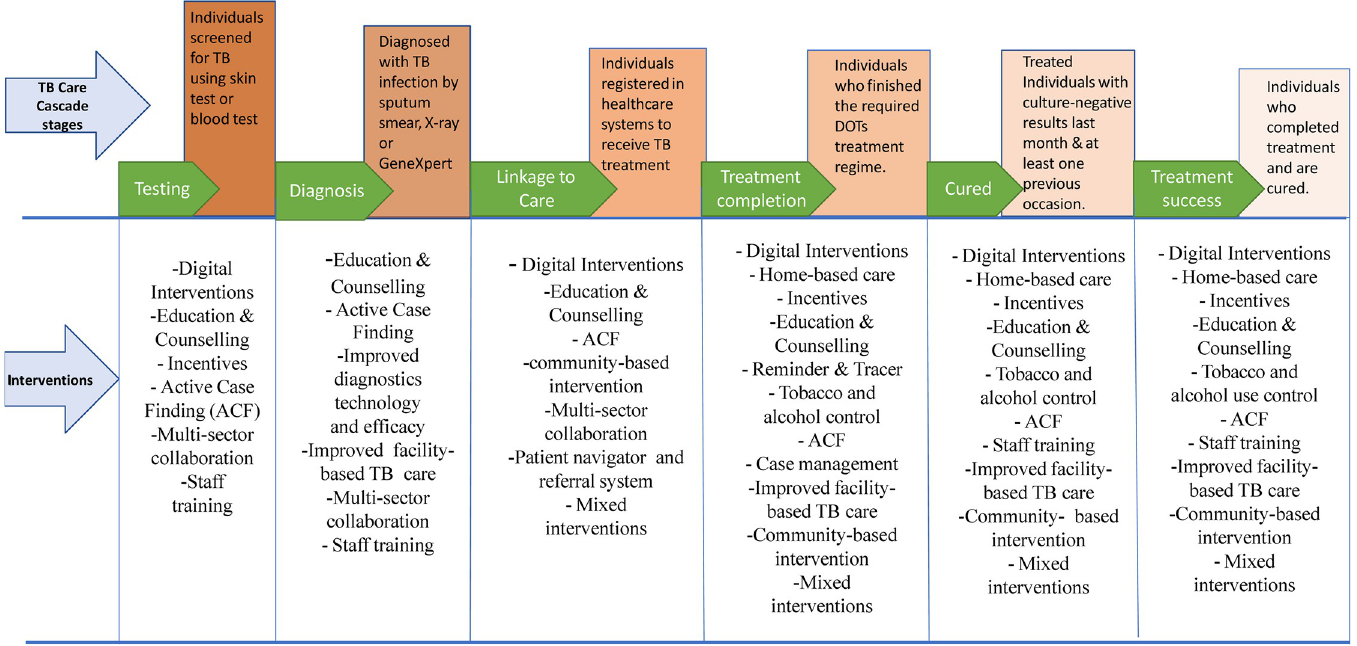
Fig 2. Summary showing the various programmatic interventions associated with outcomes at each stage of the TB care cascade.